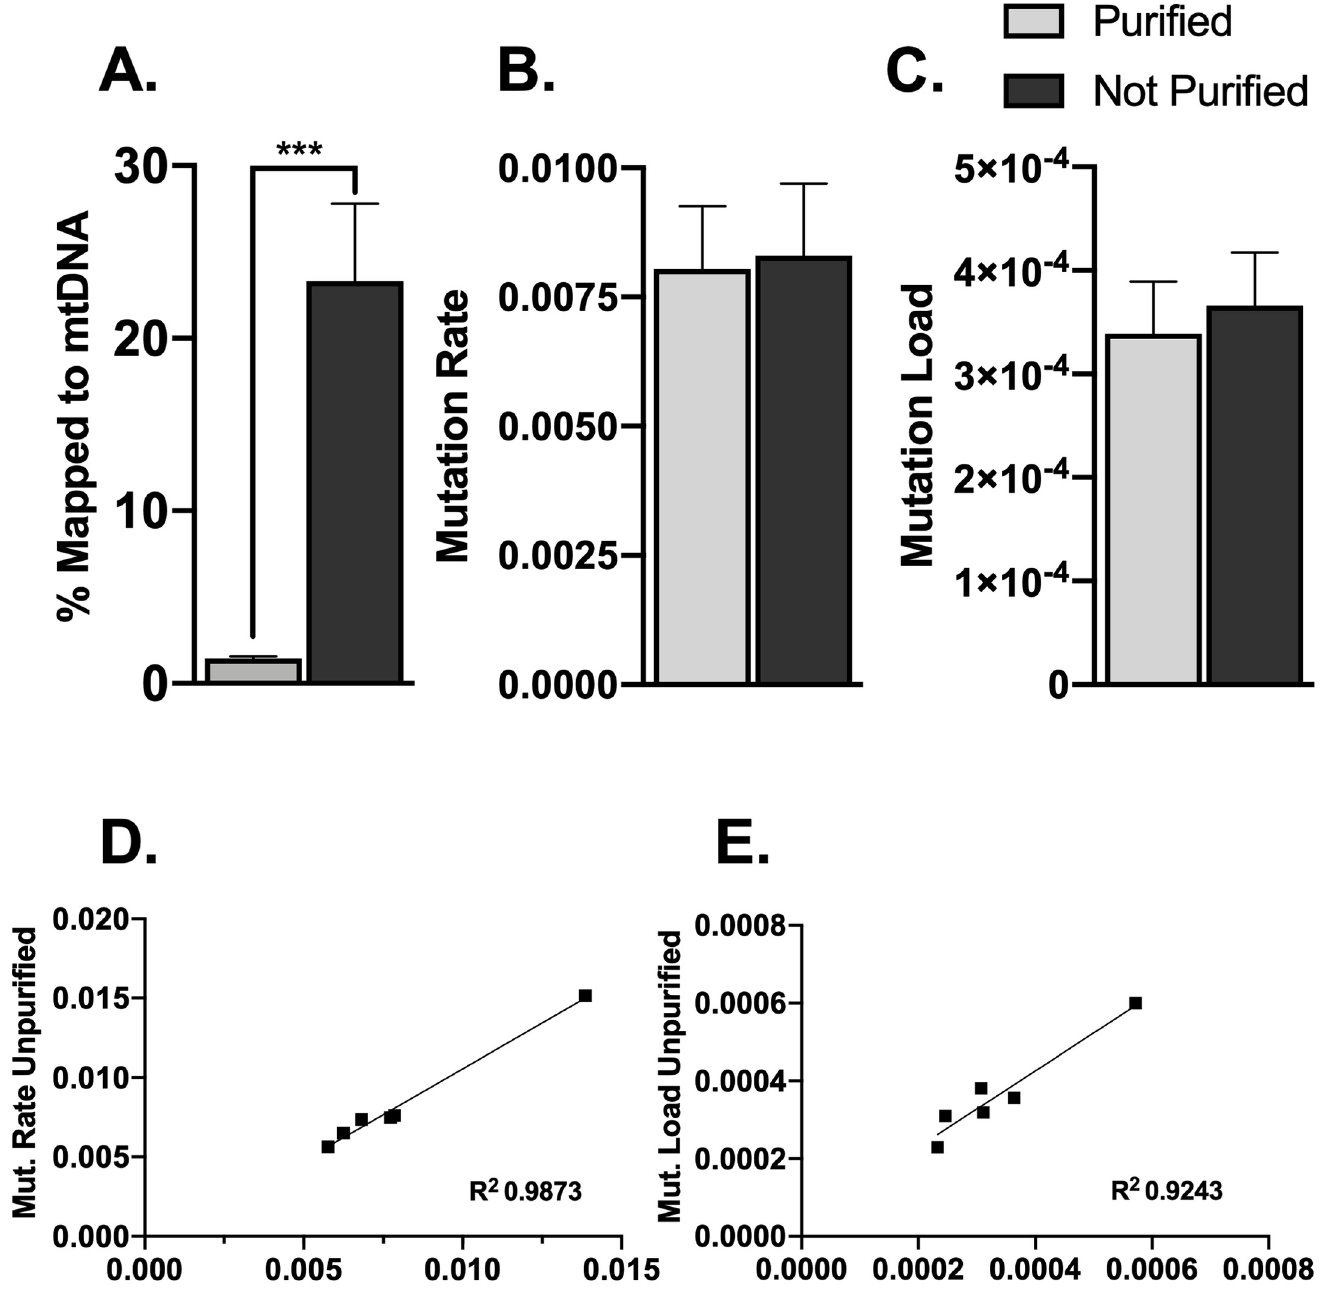
Fig 5. mtDNA purification and NUMTs. A. Percent of reads mapped to the mtDNA reference in purified and unpurified total genomic extract. B. Mutation rate in purified and unpurified samples. C. Mutation load in purified and unpurified samples. D,E. Correlations between purified and unpurified mutation rate and mutation load.(N = 6) � P < 0.05, �� P < 0.01, and ��� P < 0.001; all error bars show ±